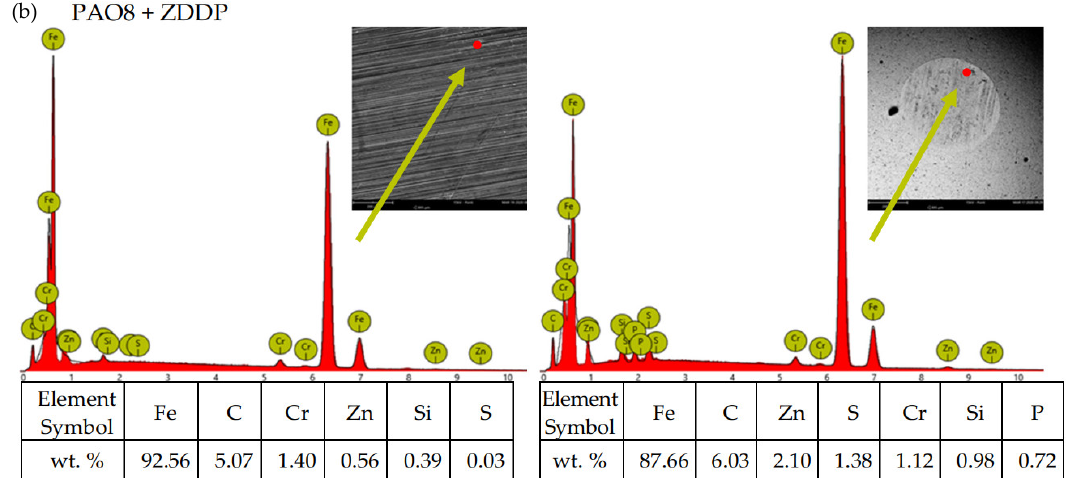
Figure 11. EDS patterns for different points of the wear track resulting from the sliding contact of the ( a ) coated and ( b ) uncoated steel discs with the steel balls—lubricant: PAO8 + ZDDP.